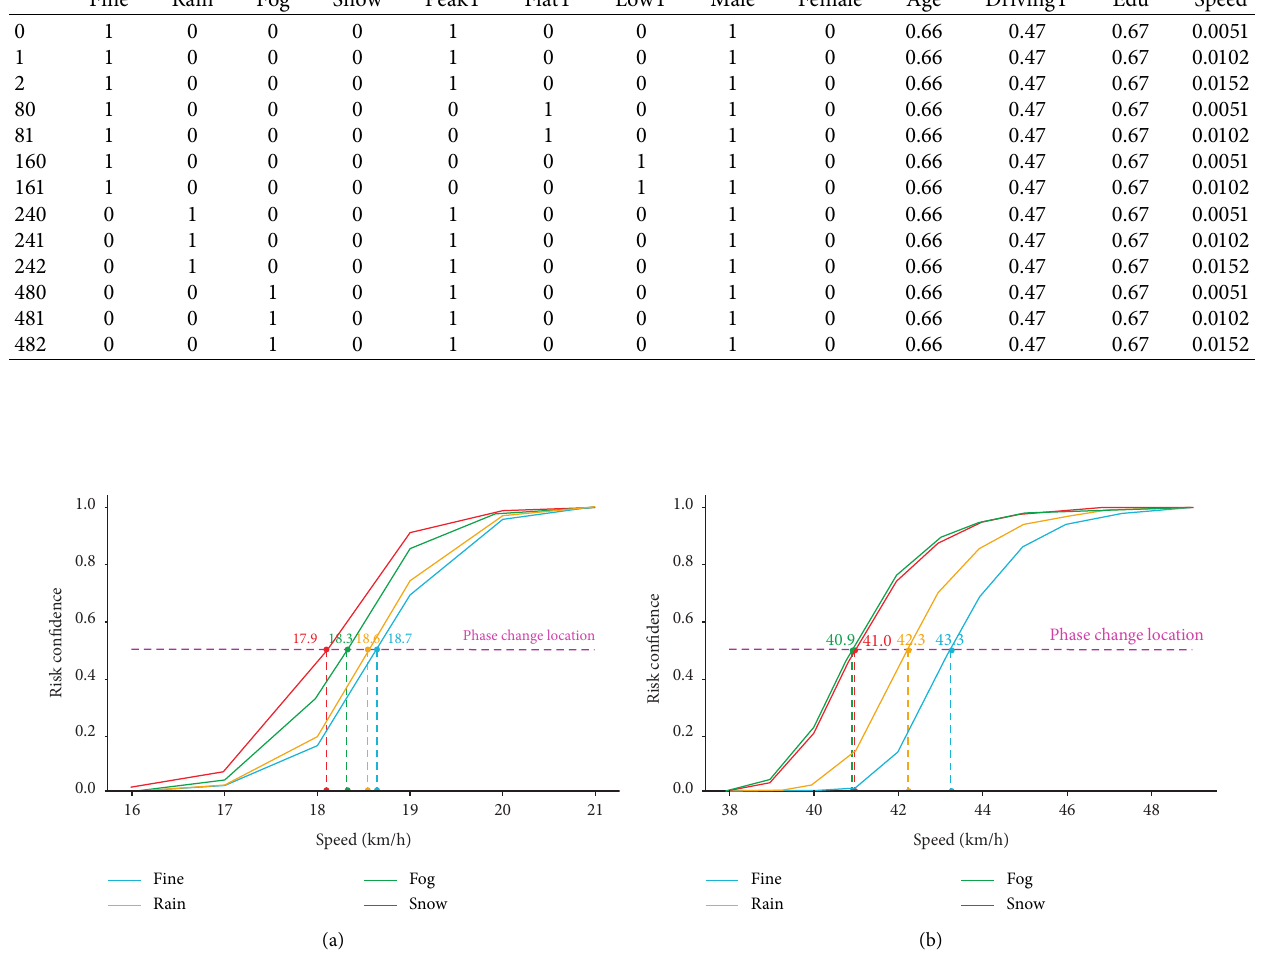
Figure 21: (a) Comparison of fatigue driving risk. (b) Comparison of driving risk probability under different weather